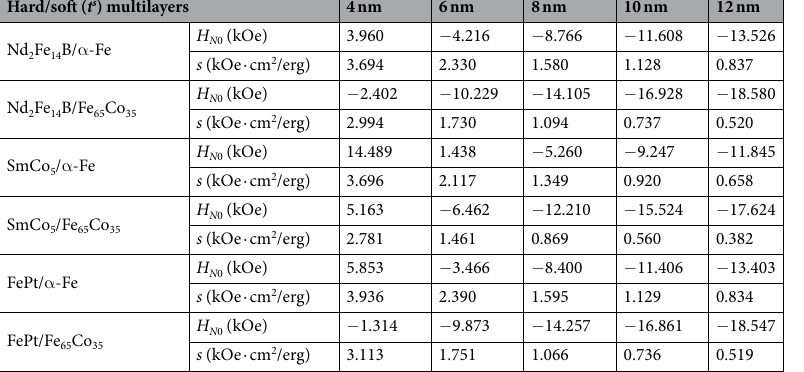
Table 2. The nucleation field at K int = 0 erg/cm 2 ( H N 0 ) and the slope ( s ) based on Eq. (12) for various hard/soft